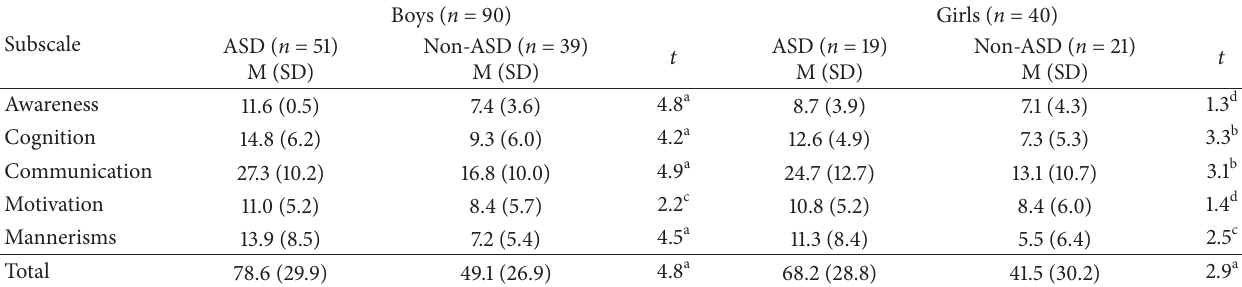
Table 1: Mean raw SRS scores of teacher ratings of children with ASD and without ASD ( 𝑁 = 130 ). Boys ( n = 90) Girls ( n = 40) Subscale ASD ( n = 51) Non-ASD ( n = 39) Non-ASD ( n = 21) 𝑡 ASD ( n = 19) 𝑡 M (SD) M (SD) M (SD) M (SD) Awareness 11.6 (0.5)